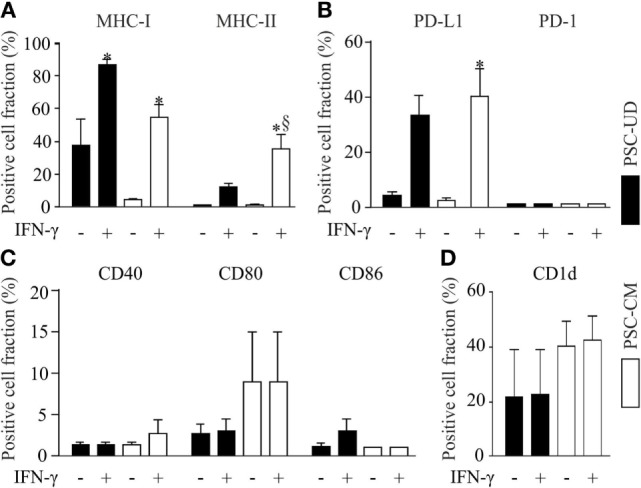
Flow cytometric analysis of cell surface markers with immune functions on undirectedly differentiated pSC-derivatives (pSC-UD) and pSC-derived cardiomyocytes (pSC-CM) with and without IFN-γ-stimulation. Cell-fractions positive for major histocompatibility complex (MHC) class I and MHC class II molecules (A), for programmed death ligand-1 (PDL-1) and PD-1 (B), for co-stimulatory molecules CD40, CD80, and CD86 (C) and for CD1d (D). *p < 0.05 vs IFN-γ unstimulated, §p < 0.05 vs pSC-UD with IFN-γ by one way ANOVA with Bonferroni’s multiple comparison post hoc test (n = 3/group).